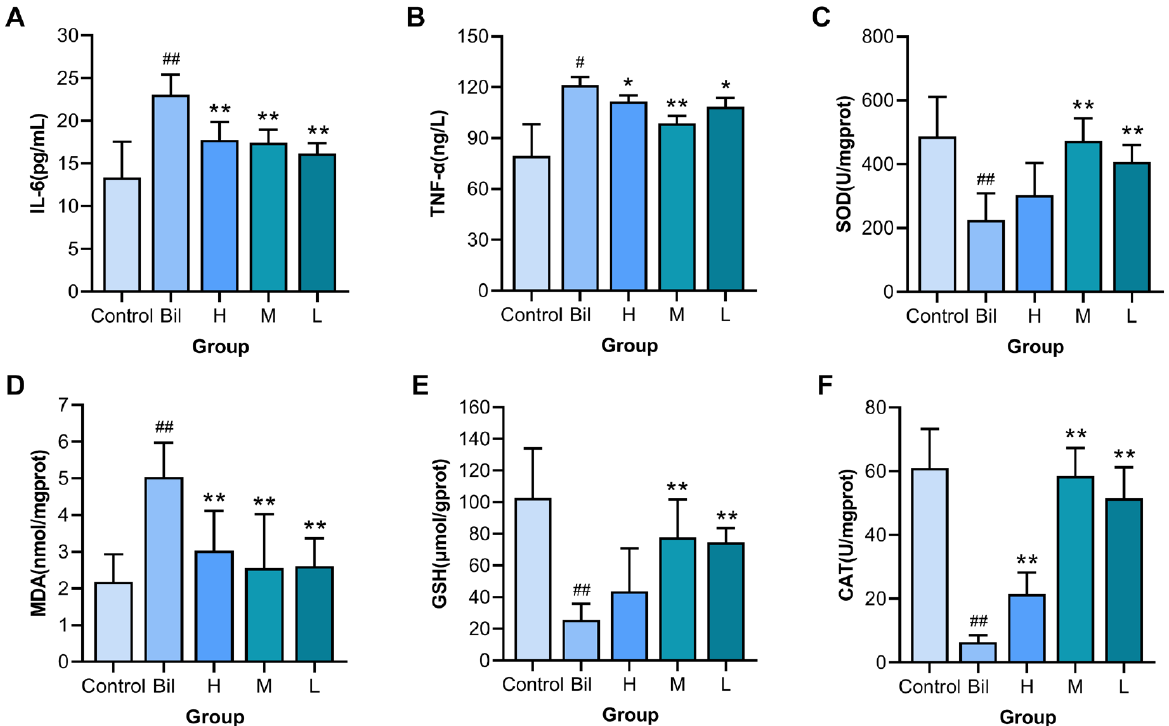
Figure 7. Effects of PGC-CDs on inflammatory factors and oxidative stress in mice. Effects of PGC-CDs on inflammatory factors interleukin-6 (IL-6) ( A ) and tumor necrosis factor- α (TNF- α ) ( B ) in serum of mice with hyperbilirubinemia model. Effects of PGC-CDs on superoxide dismutase (SOD) ( C ), malondialdehyde (MDA) ( D ), glutathione (GSH) I and catalase (CAT) ( F ) in liver tissues of mice with hyperbilirubinemia model. They were divided into control group (Control), Bil group (Bil), and high (H), medium (M) and low (L) dose PGC-CDs groups (5.80, 2.90 and 1.45 mg/kg), n = 6. Compared with the control group, ## p < 0.01, # p < 0.05. Compared with the Bil group, ** p < 0.01, * p < 0.05.